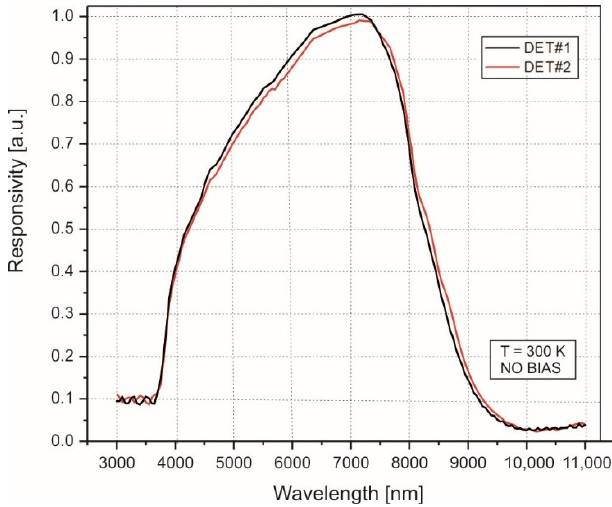
Figure 3. The relative responsivity of the applied HgCdTe photodiodes at 300